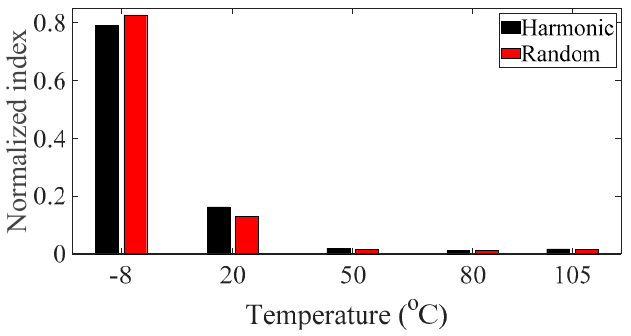
Figure 15. Normalized sensitivity index for the temperature for the two spectral loading cases.